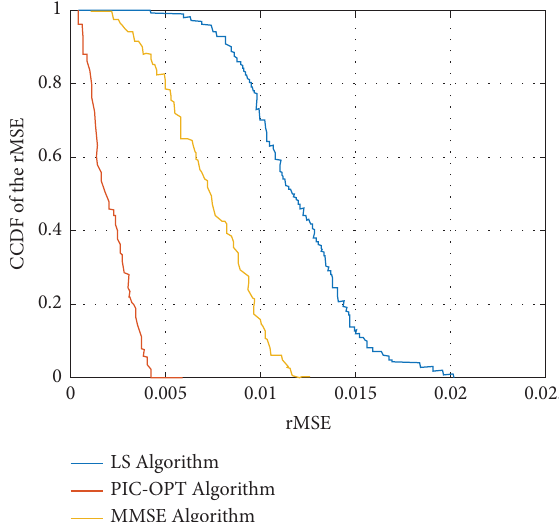
Figure 6: Te CCDF performance of the PIC-OPT algorithm compared with that of the LS algorithm and the MMSE